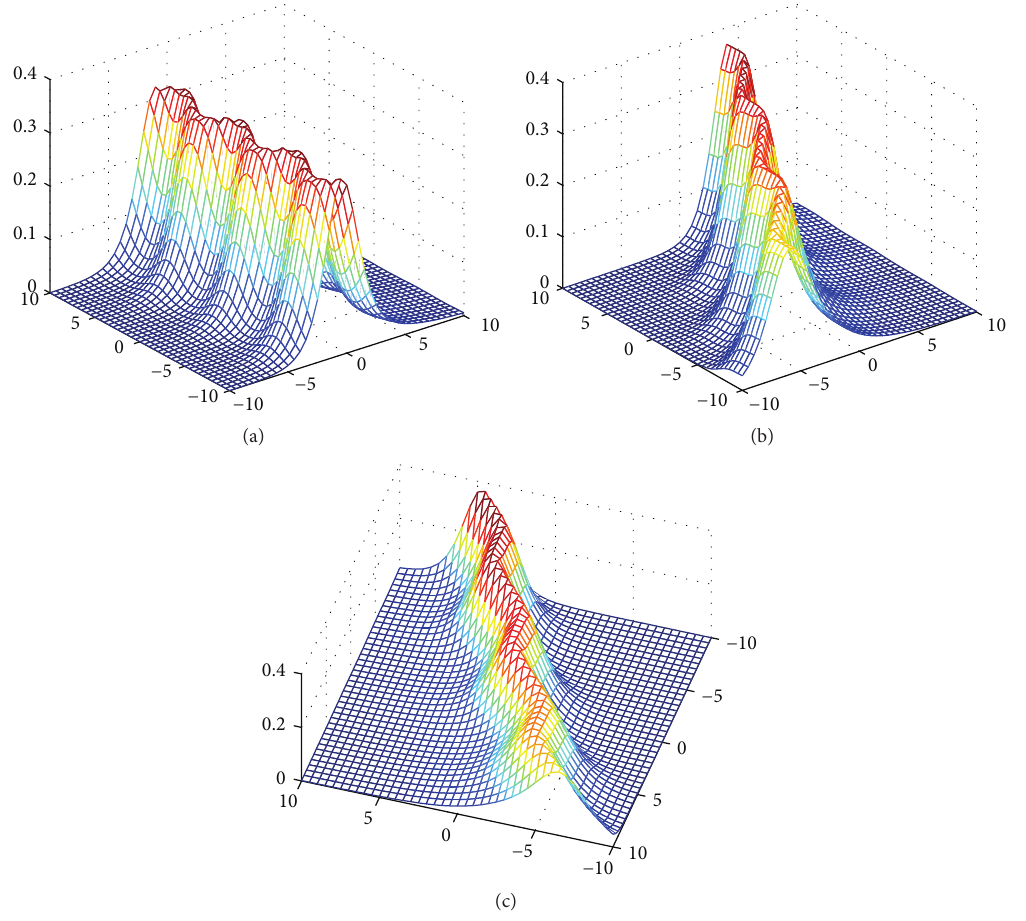
Figure 3: The process of (29) with 𝑘 1 = −0.8 , 𝑘 2 = 0.6 , 𝑘 3 = 0.4 , 𝑝 1 = 𝑝 2 = 𝑝 3 = 0 , and 𝑐(𝑡) = ℎ(𝑡) = 0 , and (a) implies 𝑏(𝑡) = cos (𝑡) , (b) implies 𝑏(𝑡) = cos (𝑡) + 1 , and (c) implies 𝑏(𝑡) = cos (𝑡) − 1